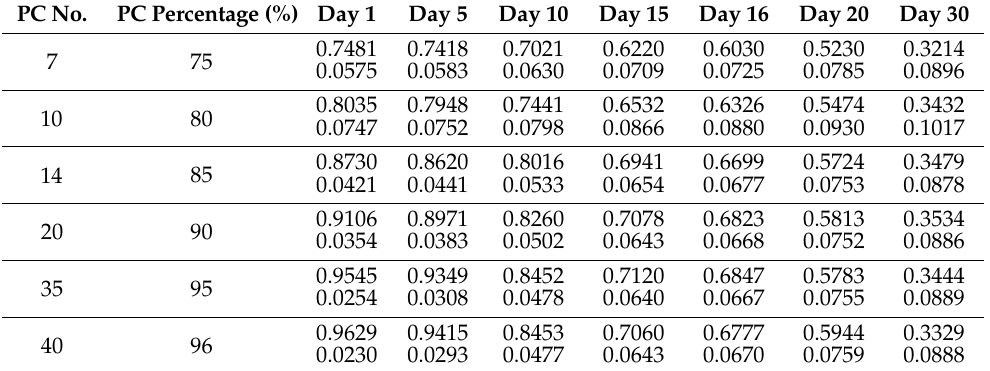
PC percentage represents the variance contribution rate.